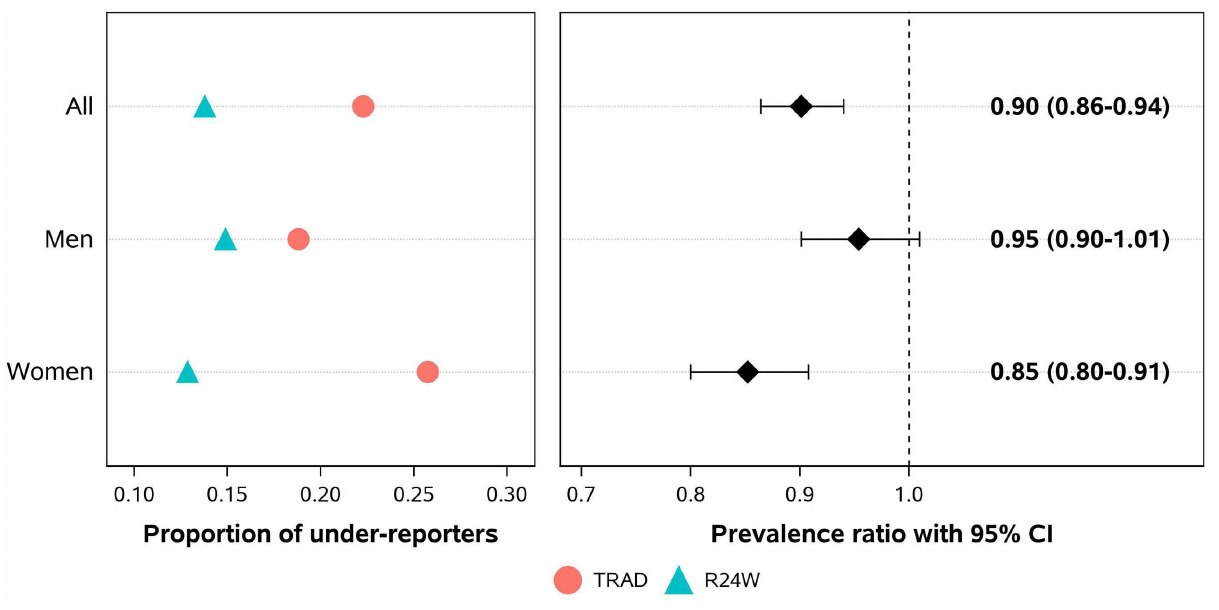
Frontiers in Nutrition |